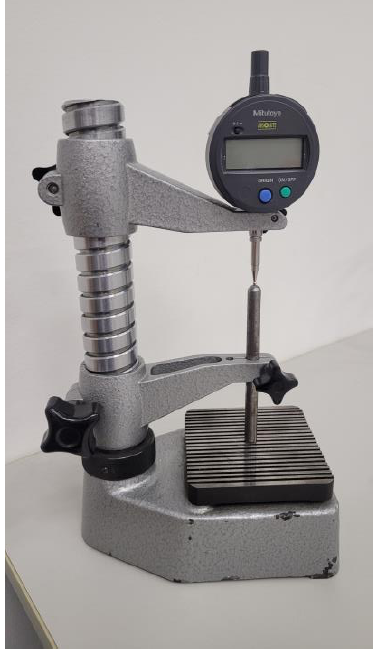
Figure 11. Dial gauge with a stand.